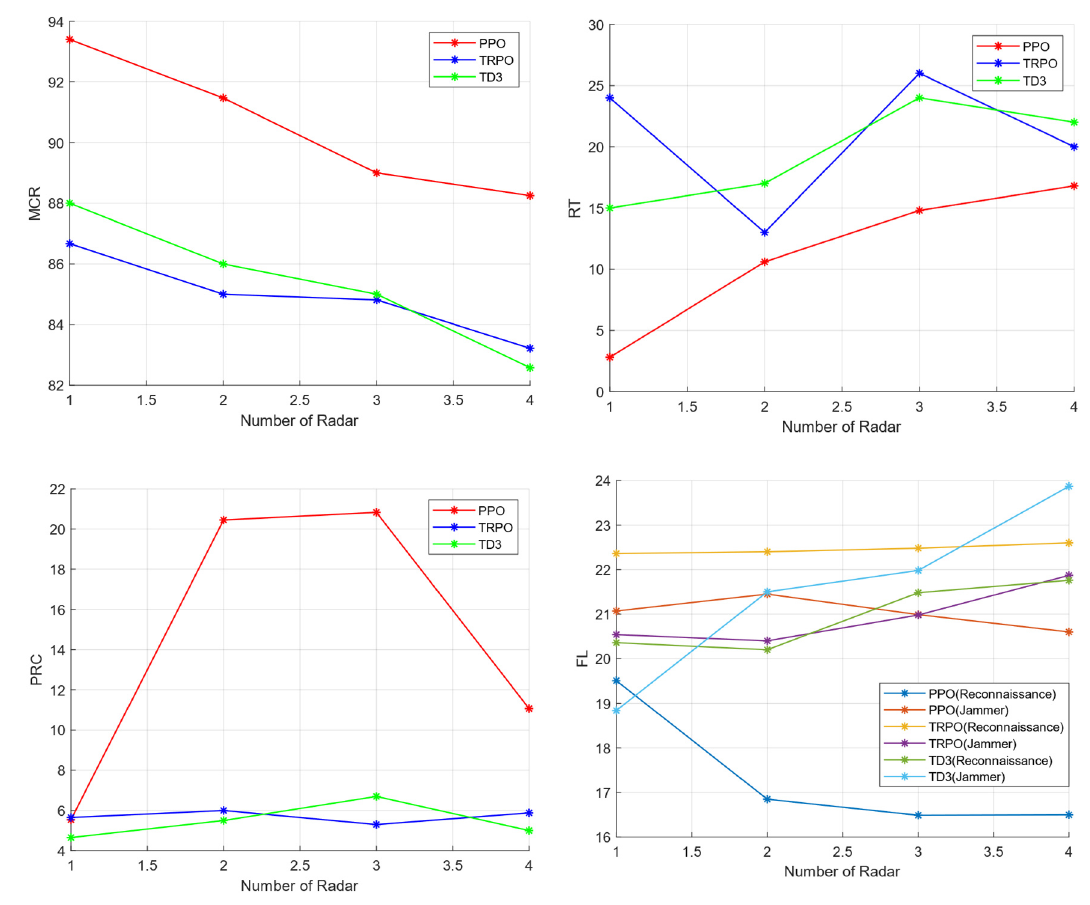
Figure 9. Variation curves of diverse evaluation indicators under different numbers of radars.